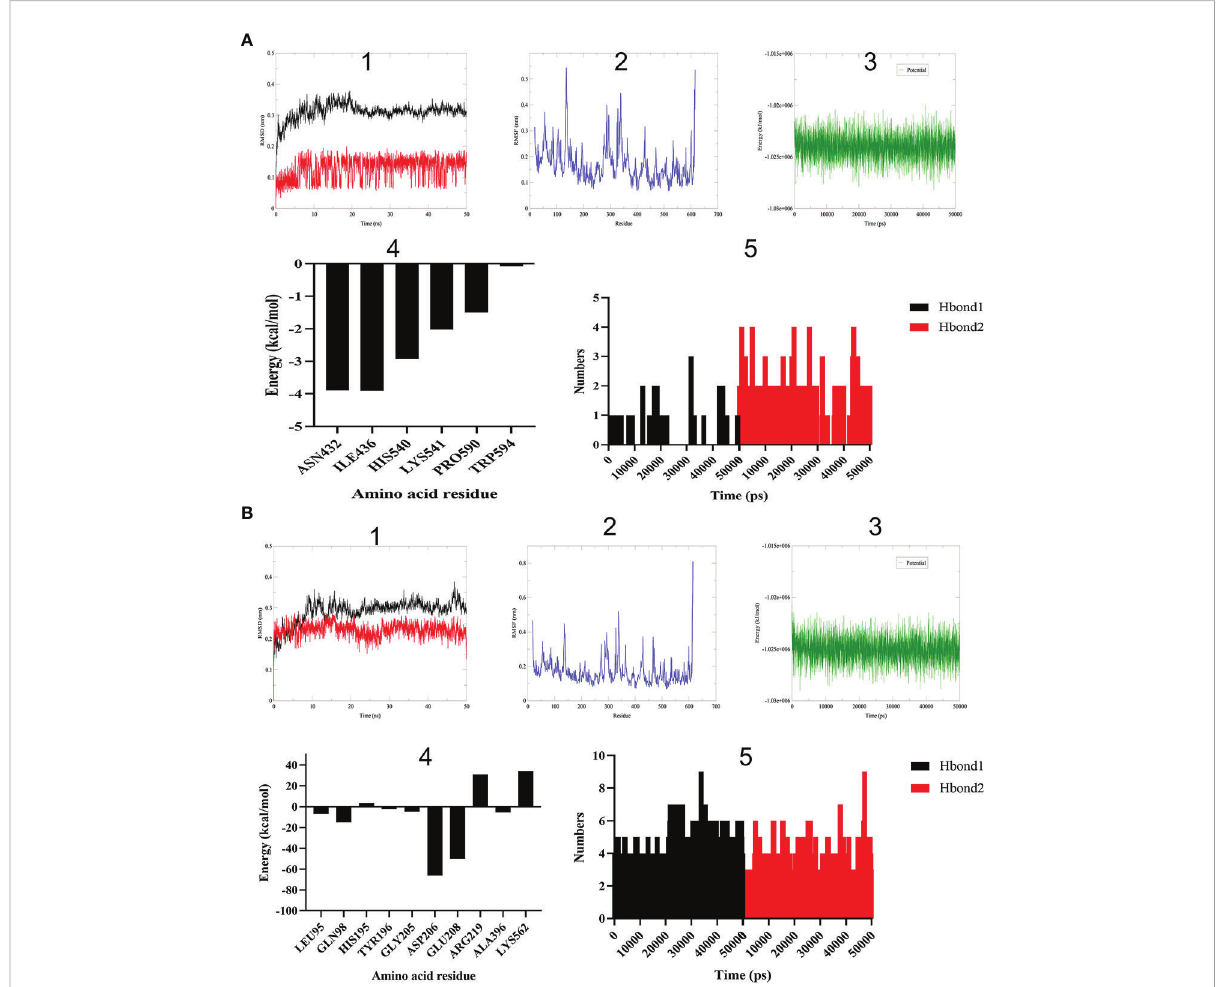
FIGURE 4 Molecular dynamics simulation of different ligands with ACE2. (A) BAR708 ― ACE2. (B) Sitagliptin ― ACE2. (1) RMSD reveals the position change between real-time conformation and initial conformation of protein-ligand complex (black: complex; red: ligand). (2) RMSF shows the fl uctuation amplitude of each atom relative to the average position. (3) Energy change of system in SPC water model. (4) Amino acid residue energy decomposition of protein complexes formed by sitagliptin and ACE2. (5) Number variation of hydrogen bonds during simulation time (Hbond1: hydrogen donor-acceptor distance less than 0.35 nm and angle less than 30 degrees. Hbond2: except for Hbond1, hydrogen donor- acceptor distance less than 0.35